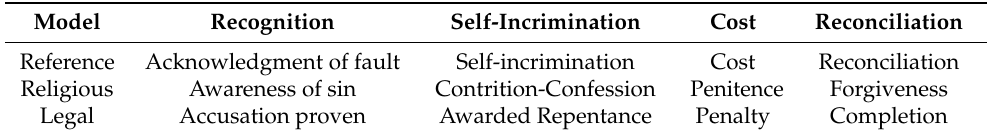
Table 1. “The objective guilt” process.